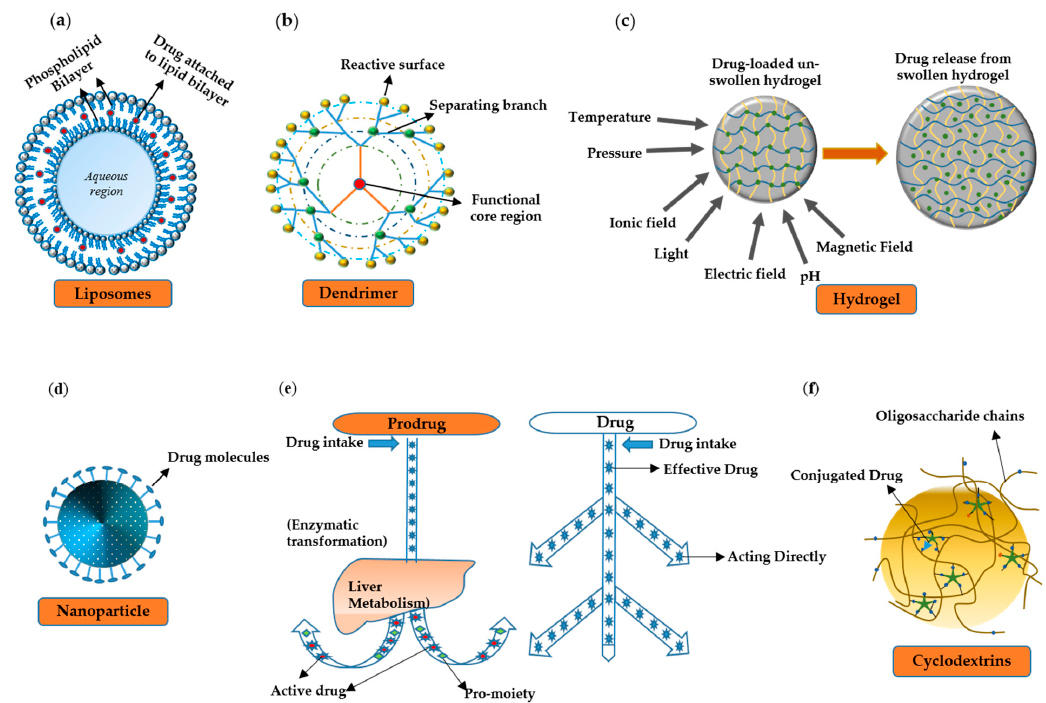
Figure 2. Drug delivery vehicles. ( a ) Liposomes are composed of phospholipids or other small-molecule compounds with various sizes, composition, and drug-loading capability. A lipid-soluble drug is attached to the lipid bilayer for safe and reliable transport to a target tissue. ( b ) Dendrimers